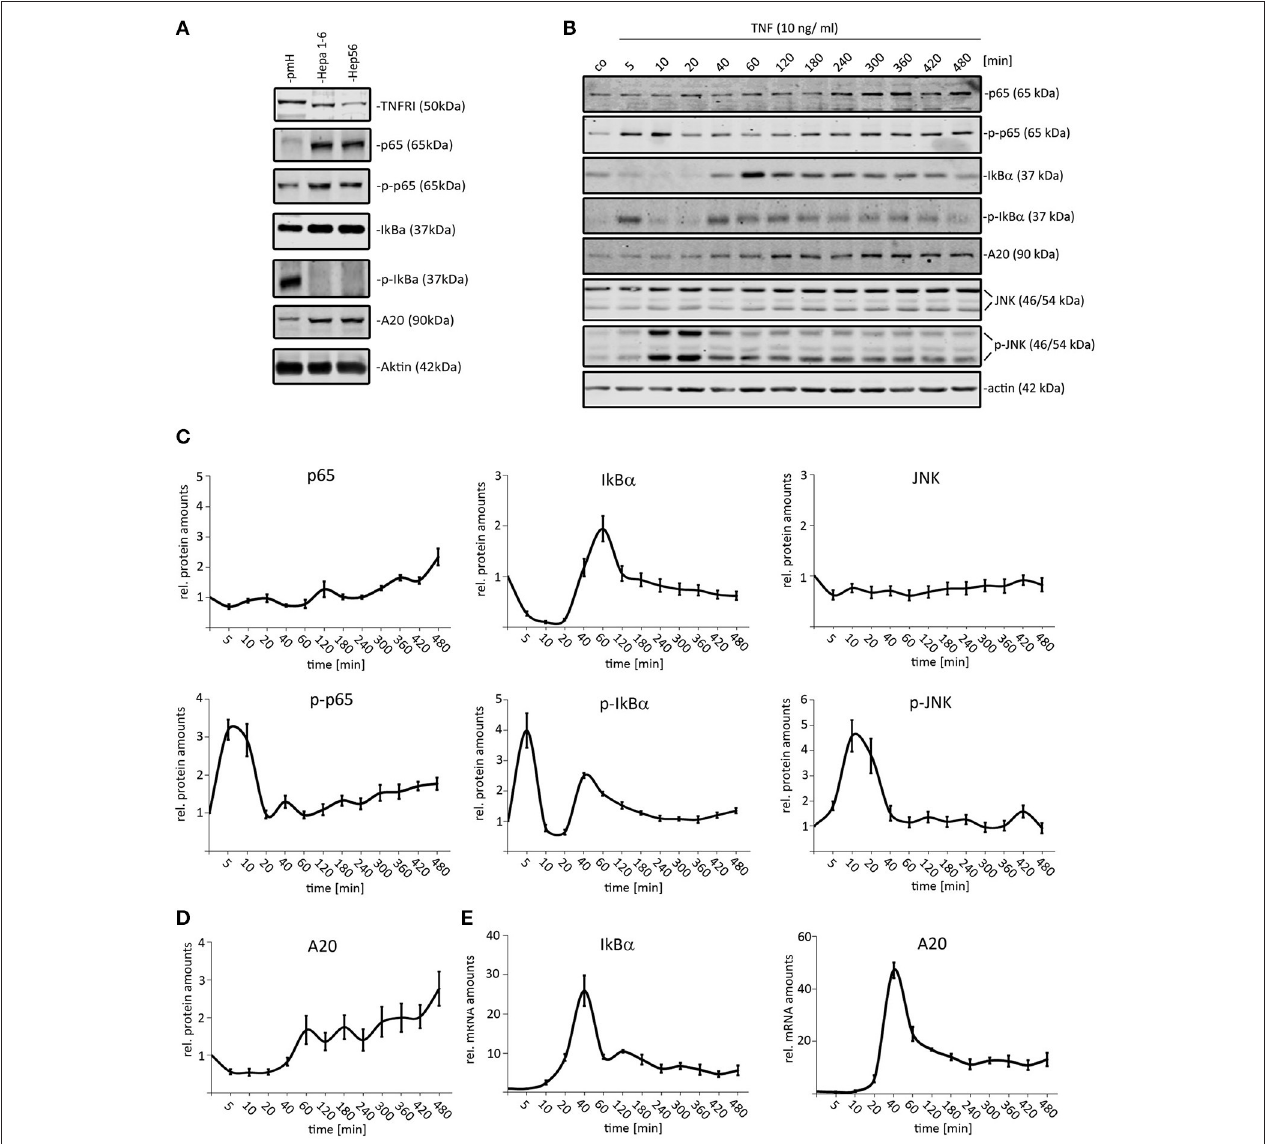
FIGURE 1 | Dynamic activation of TNF-induced NF- κ B and JNK pathways in mouse liver cancer cells. (A) Comparison of p65/phospho-p65, I κ B- α /phospho-I κ B- α , TNFR1, and A20 protein amounts in primary murine hepatocytes (pmH) and 2 mouse HCC cell lines (Hepa1-6, Hep56). The mean TNFR1 difference between both HCC cell lines and hepatocytes was calculated based on three independent experiments followed by signal quantification. (B) Exemplary Western immunoblots of protein extract isolated from Hepa1-6 cells after administration of TNF (10 ng/ml) for the indicated time-points (untreated and 5–480 min after stimulation). Signals for p65/phospho-p65, I κ B α /phospho-I κ B α , JNK/phospho-JNK, and the negative feedback regulator A20 were quantified and normalized to the respective loading control (actin). (C) Relative protein amounts of NF- κ B and JNK pathways constituents in Hepa1-6 cells after single TNF administration (10 ng/ml). (D) Relative protein amounts of A20 in Hepa1-6 cells after single TNF administration (10 ng/ml). (E) Relative mRNA levels of A20 and I κ B α after single TNF stimulation. Graphs in (C–E) summarize the results from three independent experiments. Bars in panel (C–E) represent standard